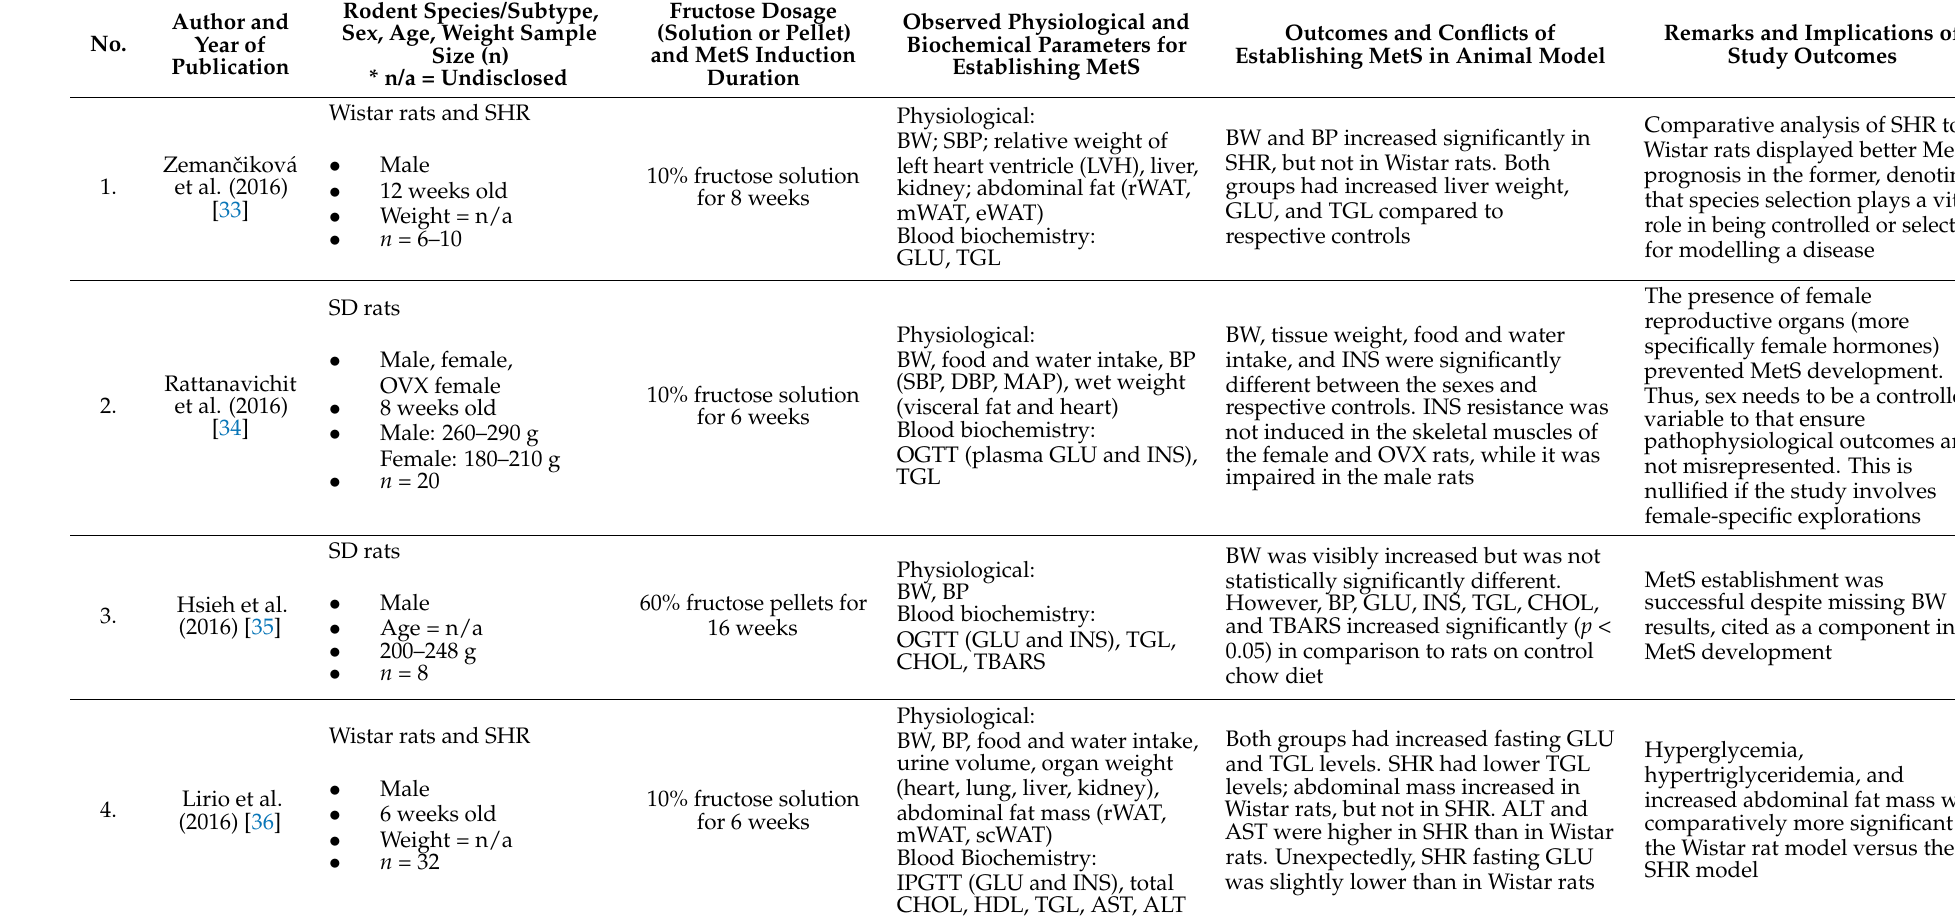
Table 1. Main factors attributed to MetS establishment in rodent